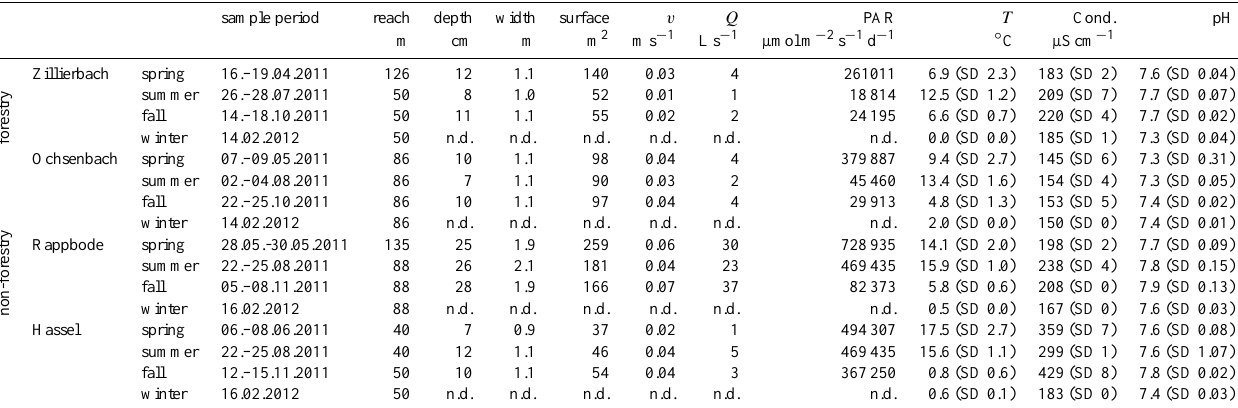
Table 1. The general stream characteristics of the investigated streams ∗ . sample